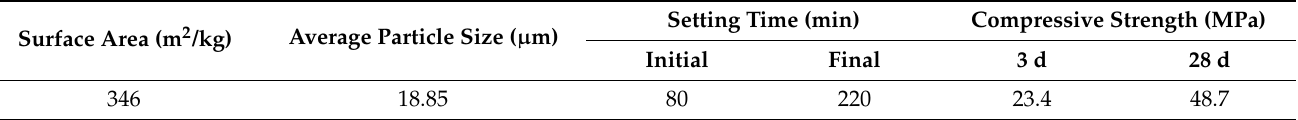
Table 2. Physical properties of